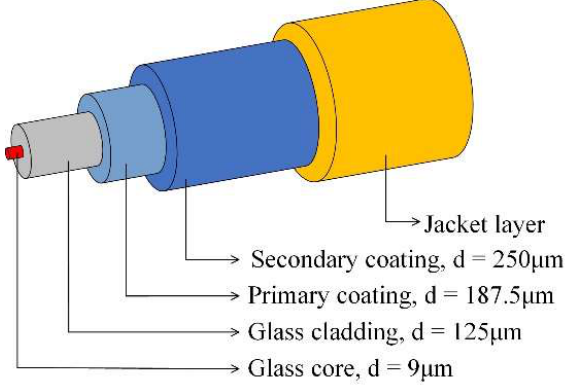
Figure 4. Configuration of the FBG-optical fiber sensor.